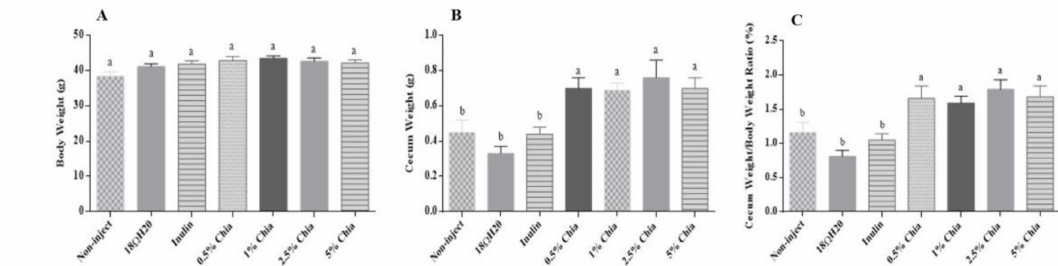
Figure 2. The e ff ect of chia on the: ( A ) body weight; ( B ) cecum weight; and ( C ) cecum weight / body weight ratio (%). Values are the means ± SEM n = 15. a,b Within a column, means without a common letter are significantly di ff erent ( p < 0.05).